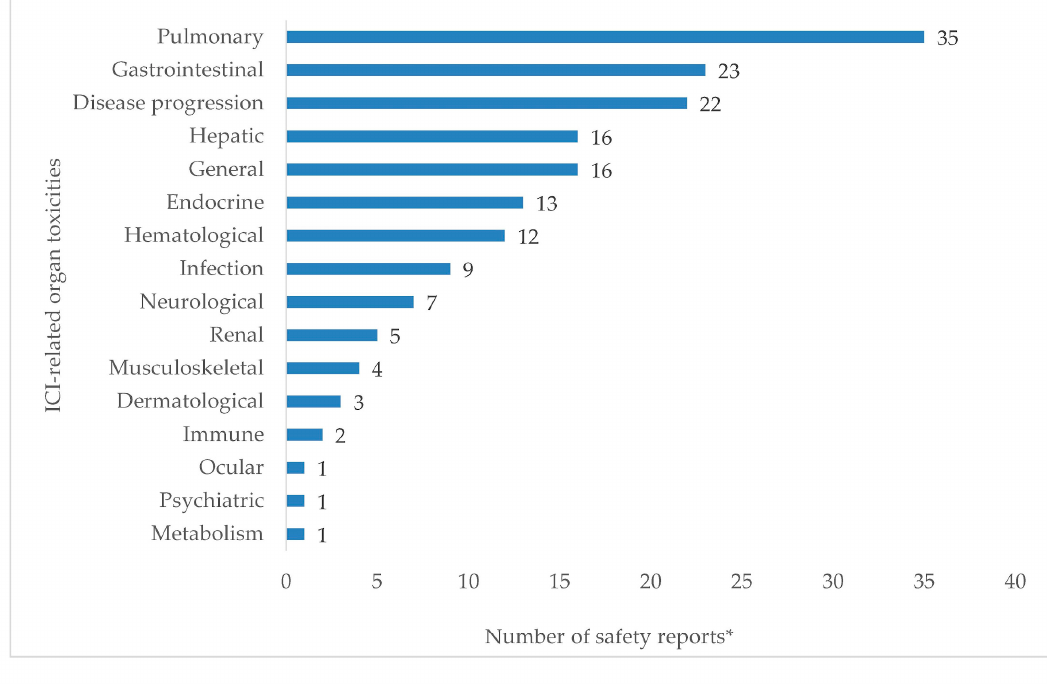
Figure 3. Organ toxicities reported with immune checkpoint inhibitors in the group of control safety reports.